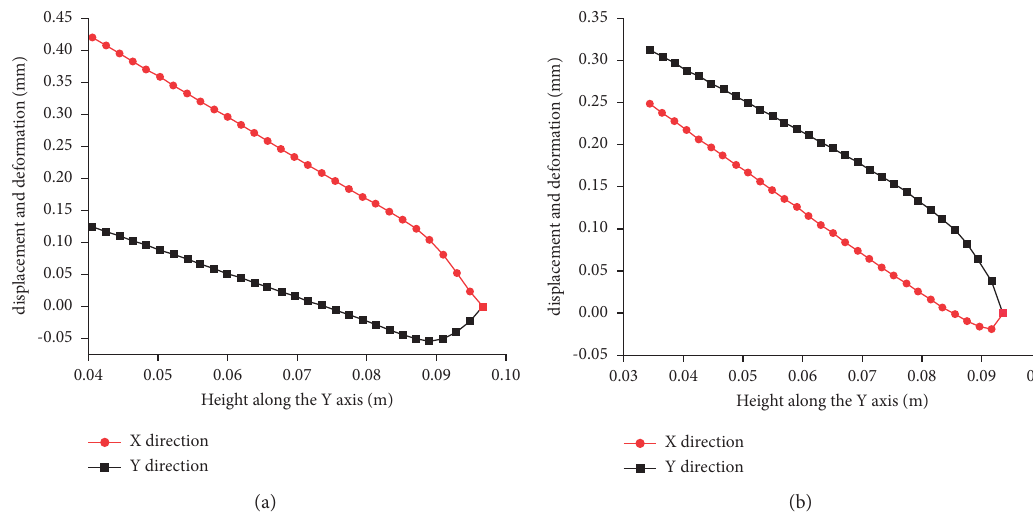
Figure 23: Variation of displacement and deformation along the height in equilibrium state. (a) Displacement and deformation along the height of Line 1. (b) Displacement and deformation along the height of Line 2.